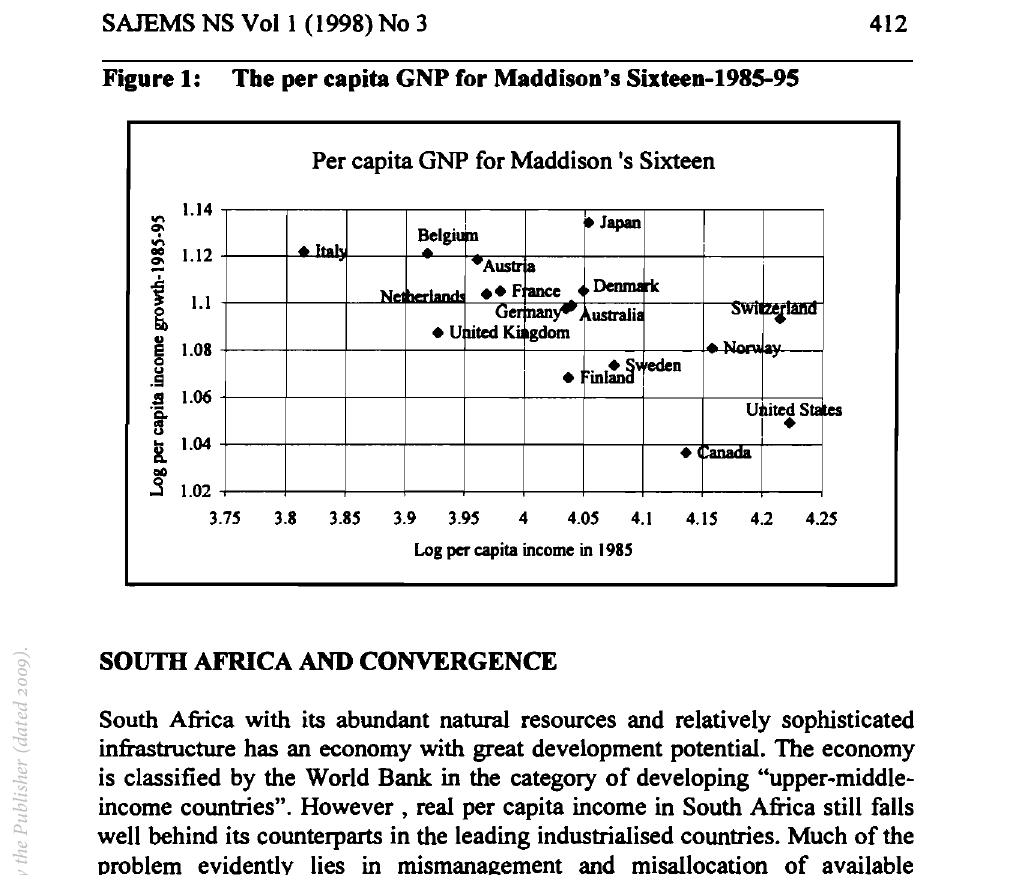
Figure I: The per capita GNP for Maddison's Sixteen-198S-95 Per capita GNP for Maddison's